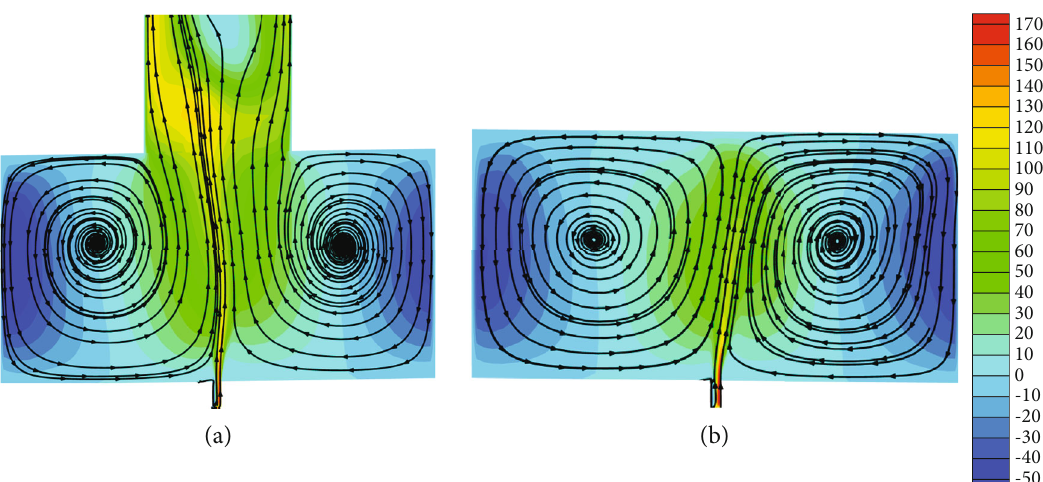
H = 0 : 62 : (a) plane at r /